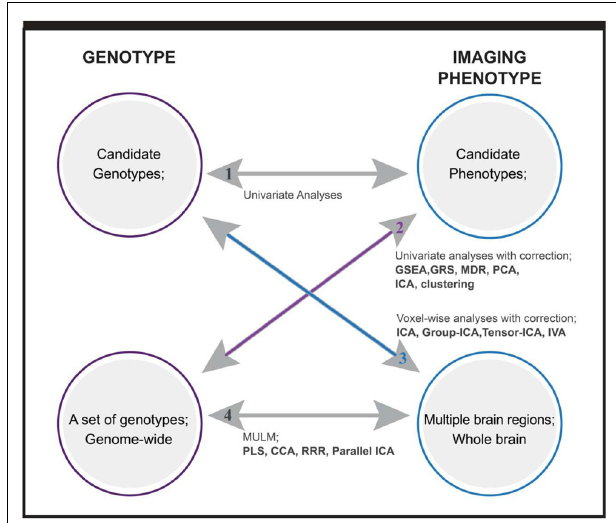
FIGURE 1 | Overview of imaging genetic studies and methods applied. Category 1: candidate genotype with candidate phenotype. Category 2: sets of genotypes with candidate phenotype. Category 3: candidate genotype with multiple imaging phenotypes. Category 4: sets of genotypes with multiple imaging phenotypes. Methods written in bold are multivariate analysis methods. GSEA: gene set enrichment analysis; GRS: genetic risk score; MDR: multifactor dimensionality reduction; PCA: principal component analysis; ICA: independent component analysis; IVA: independent vector analysis; MULM: mass univariate linear model; PLS: partial least square; CCA: canonical component analysis; RRR: reduced rank